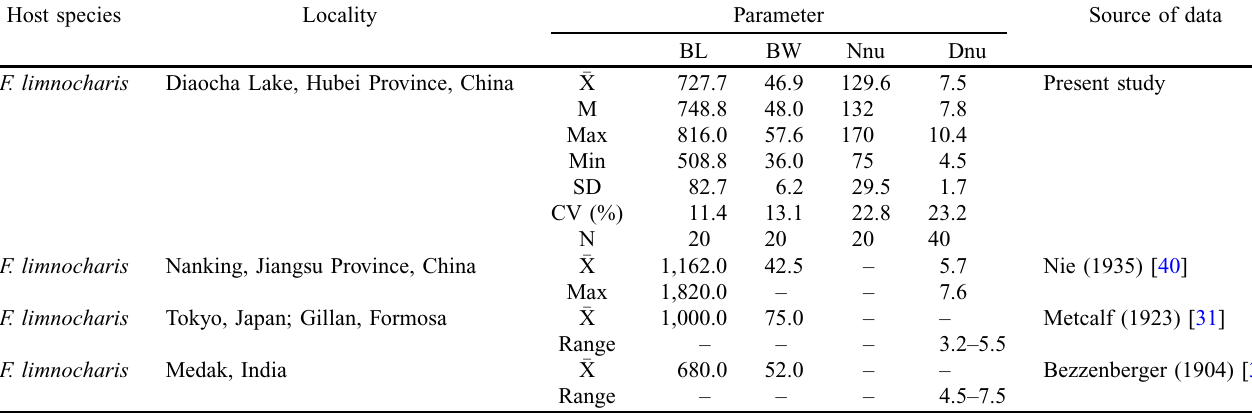
Table 2. Biometrical data (in l m) on Cepedea longa and comparison with former reports. Host